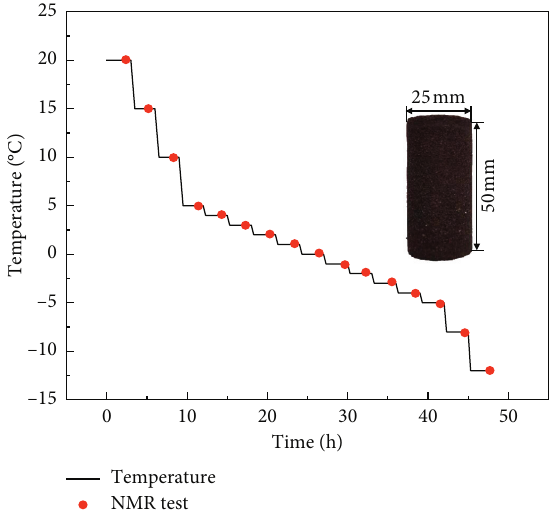
Figure 6: Schematic diagram showing freezing process and associated testing times.